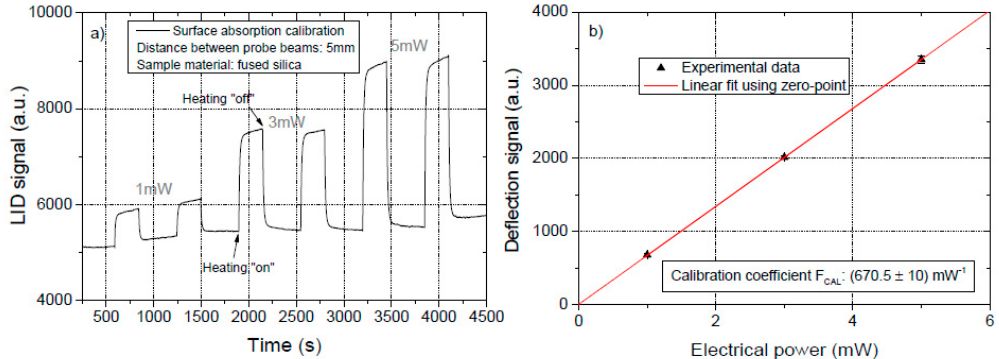
Figure 3. ( a ) Signal from position sensitive detector (PSD) during electrical calibration procedure for surface absorption measurement on fused silica samples of geometry ∅ = 1”, thickness 1 mm. ( b ) Deflection signal as function of the electrical power for the calibration procedure in Figure 3a. The slope of the linear fitting defines the calibration coefficient F CAL .